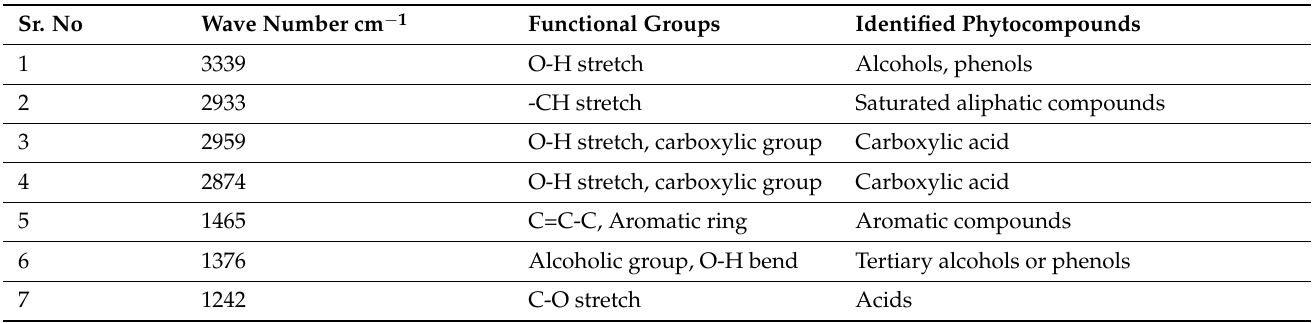
Table 3. FTIR interpretation of compounds of methanolic extract of Thymus vulgaris